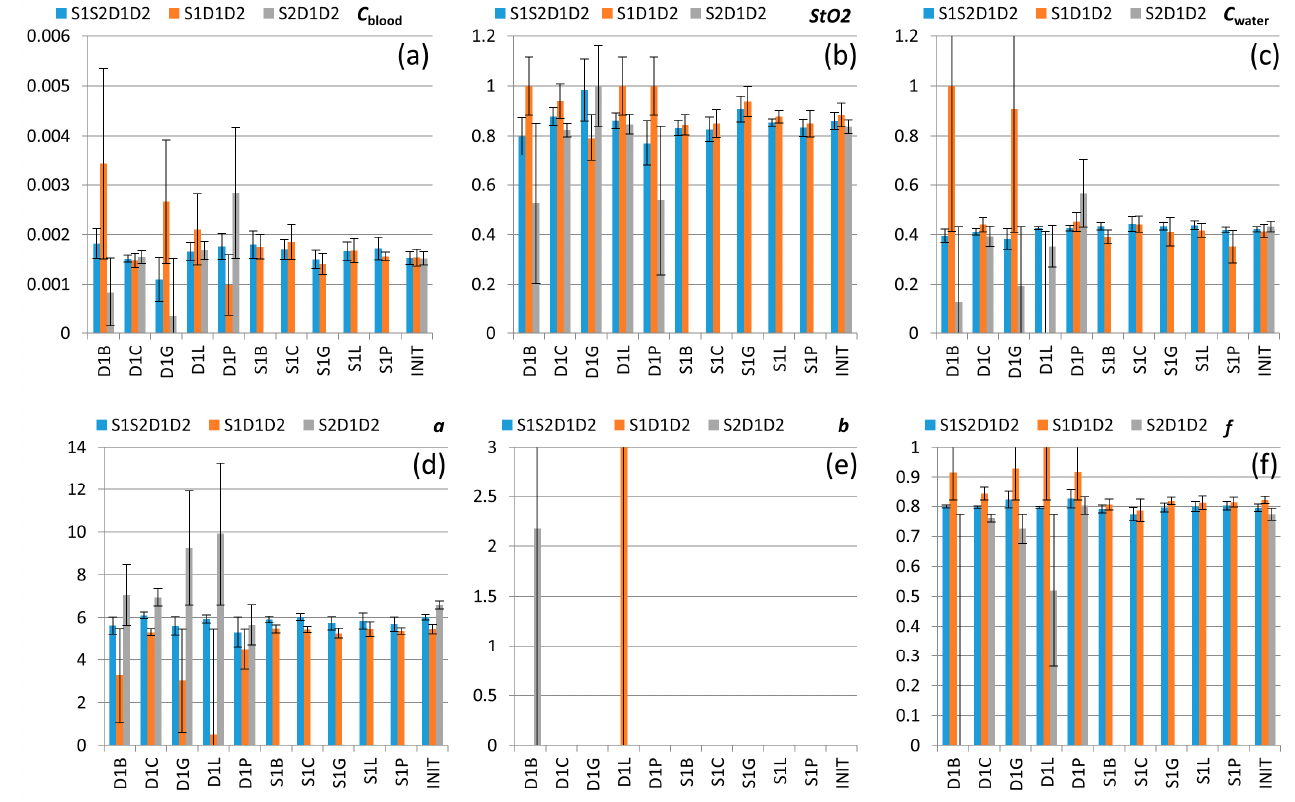
Figure 7. Values of C blood ( a ), StO 2 ( b ), C water ( c ), a in mm − 1 ( d ), b ( e ), and f ( f ) reconstructed from the experimental extinction spectra using S1S2D1D2, S1D1D2, and S2D1D2 approaches and averaged over 3 measurements for each of the 10 perturbations (Table 1) and over 6 measurements for INIT data. Error bars show deviations in the corresponding reconstructed values in the series of the experiment. All values of b are below 10 − 8 , except the two corresponding to the perturbations D1B and D1L, which lead to largest deviations in the reconstructed extinction spectra from the unperturbed one (see Figure 4c,e).